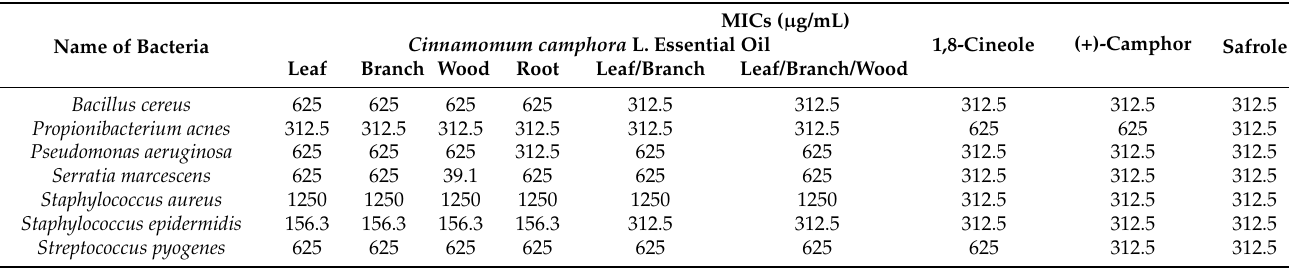
Table 4. Minimum inhibitory concentrations (MICs) of the Cinnamomum camphora L. essential oil against the tested bacterial strains.